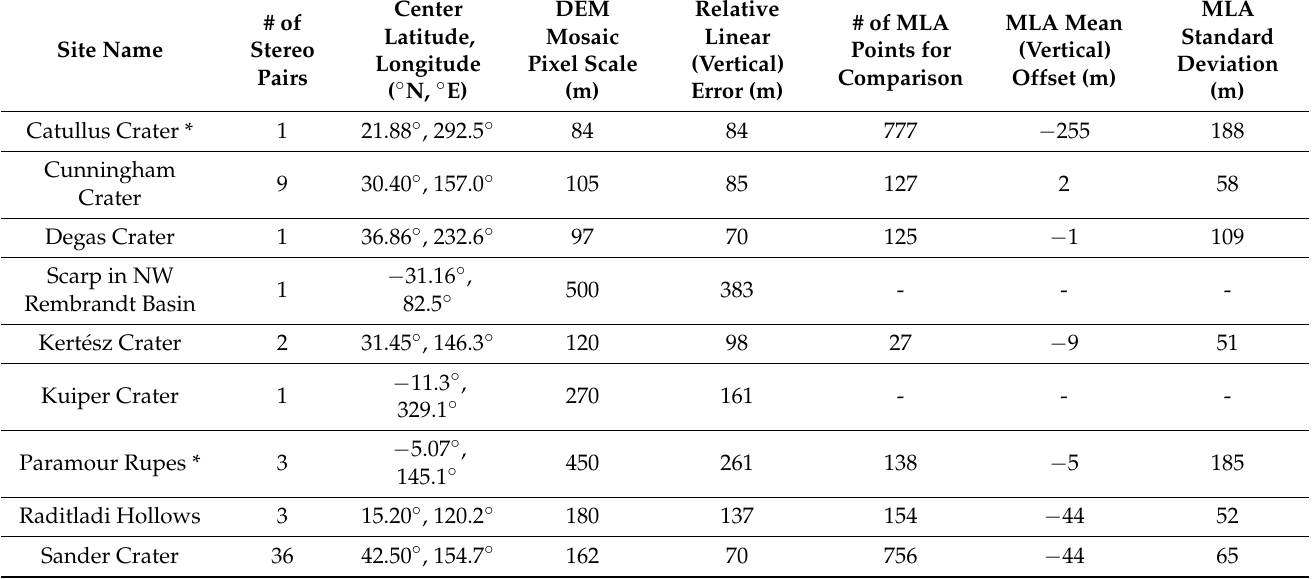
Table 3. Summary data and error analysis for completed